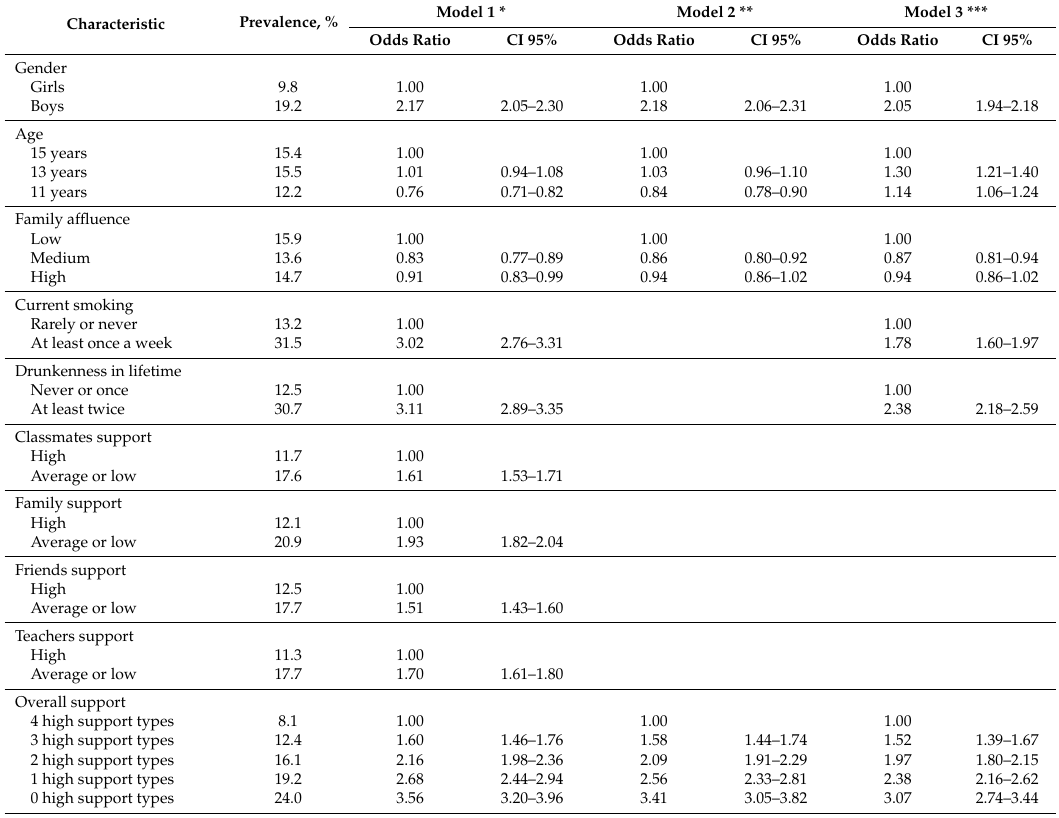
Table 7. Bullying and associated factors in all countries: logistic